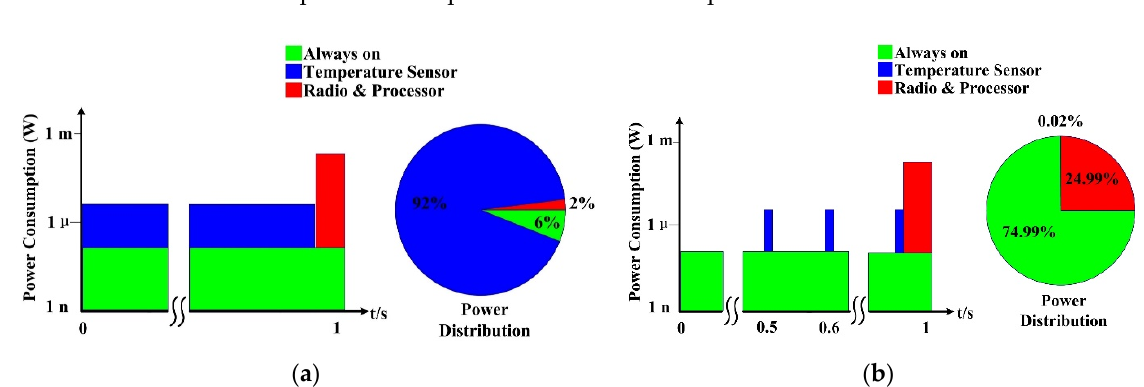
Figure 1. Operation scenarios of BIoT with ( a ) an always-on temperature sensor; ( b ) a duty-cycling temperature sensor.